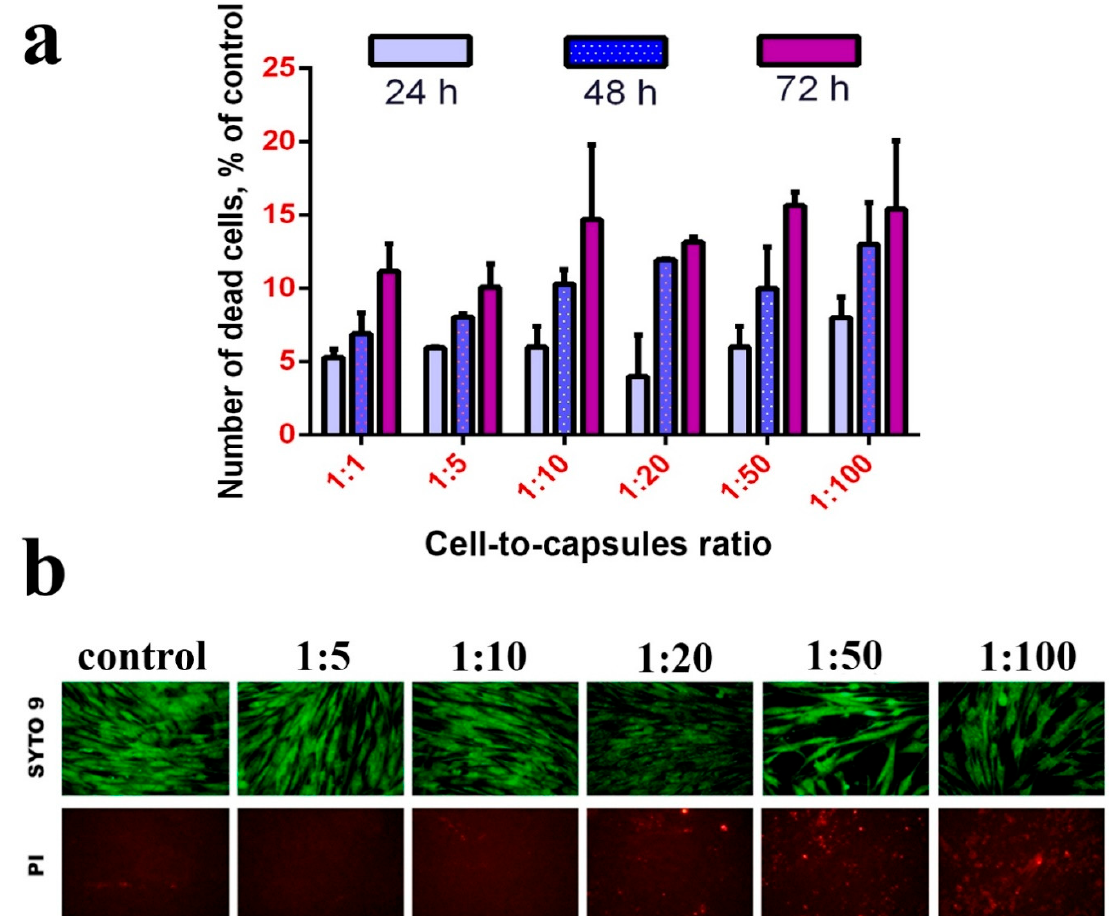
Figure 5. LIVE/DEAD assay of hMSC after incubation (24, 48 and 72 h) with nanoceria-loaded polyelectrolyte microcapsules ( a ). Micrographs of hMSC after incubation (24 h) with nanoceria-loaded polyelectrolyte microcapsules ( b ). Control: without the addition of microcapsules.